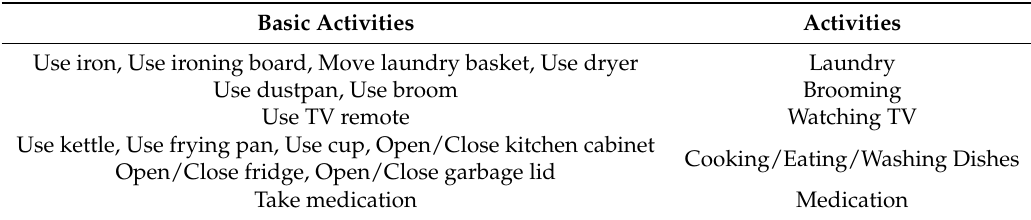
Table 6. Activities recognized based on Estimotes attached to